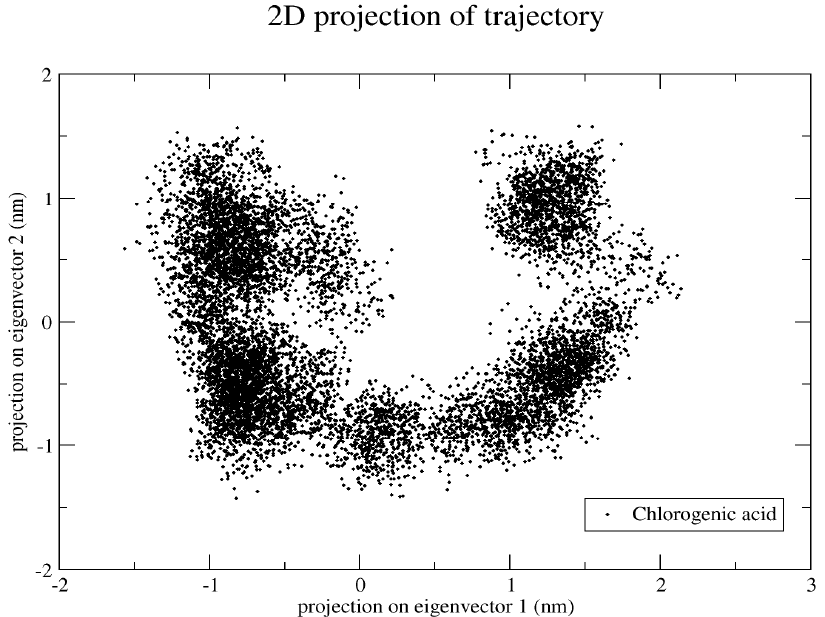
Figure 16. Projection of the motion of a protein in phase along the principal components (PC1 and PC2).